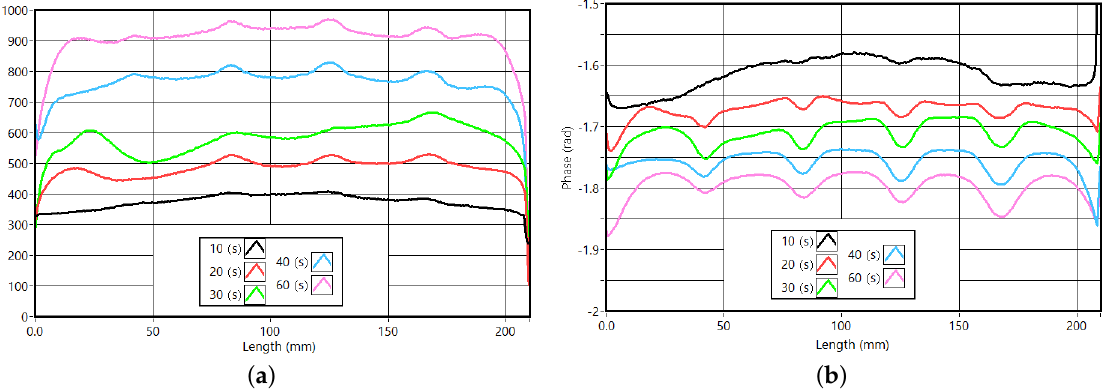
Figure 18. Results from the PMMA validation tests. ( a ) Average amplitude profiles. ( b ) Average phase profiles.